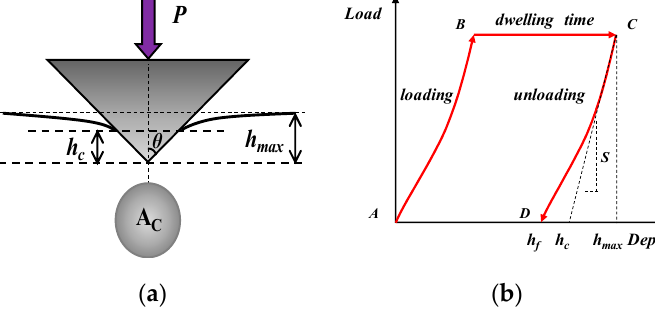
Figure 3. Nanoindentation test. ( a ) Geometry of the Berkovich tip, ( b ) typical nanoindentation load–depth curve.